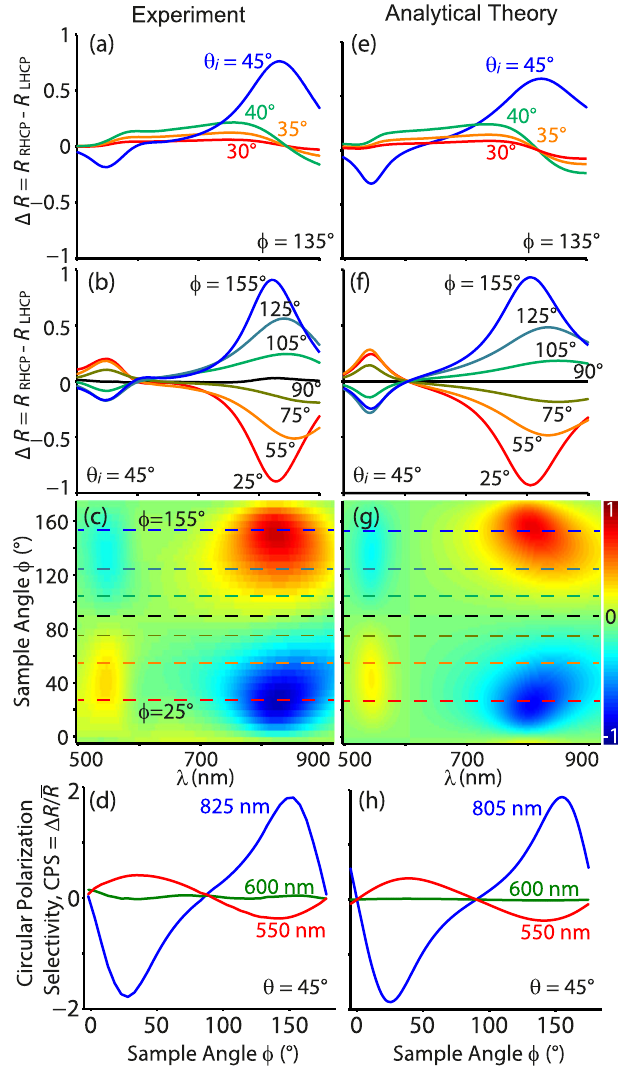
FIG. 3. Helicity-dependent reflections as function of θ i and ϕ . (a) Δ R at ϕ ¼ 135 ° for varying θ i below and above θ c . (b),(c) Δ R at θ i ¼ 45 ° with varying ϕ . (d) The CPS for the two in-plane resonance wavelengths (550 and 825 nm) and 600 nm, as found from (c). (e) – (h) Analytical theory based on two in-plane orthogonal short-axis resonance. Note that there is no spectral differ- ence between ϕ ¼ 0 ° and 90°. The system and its mirror image are identical when one of the symmetry axes of the sample is lined up with the plane of incidence, which thus corresponds to a vanishing extrinsic chirality.